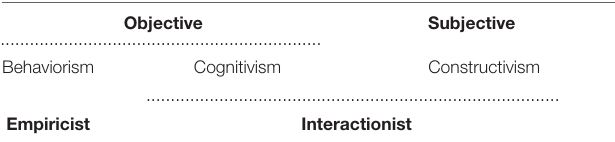
TABLE 2 | Categorization of selected approaches based on Driscoll (2005) and Scaglia et al. (2014).